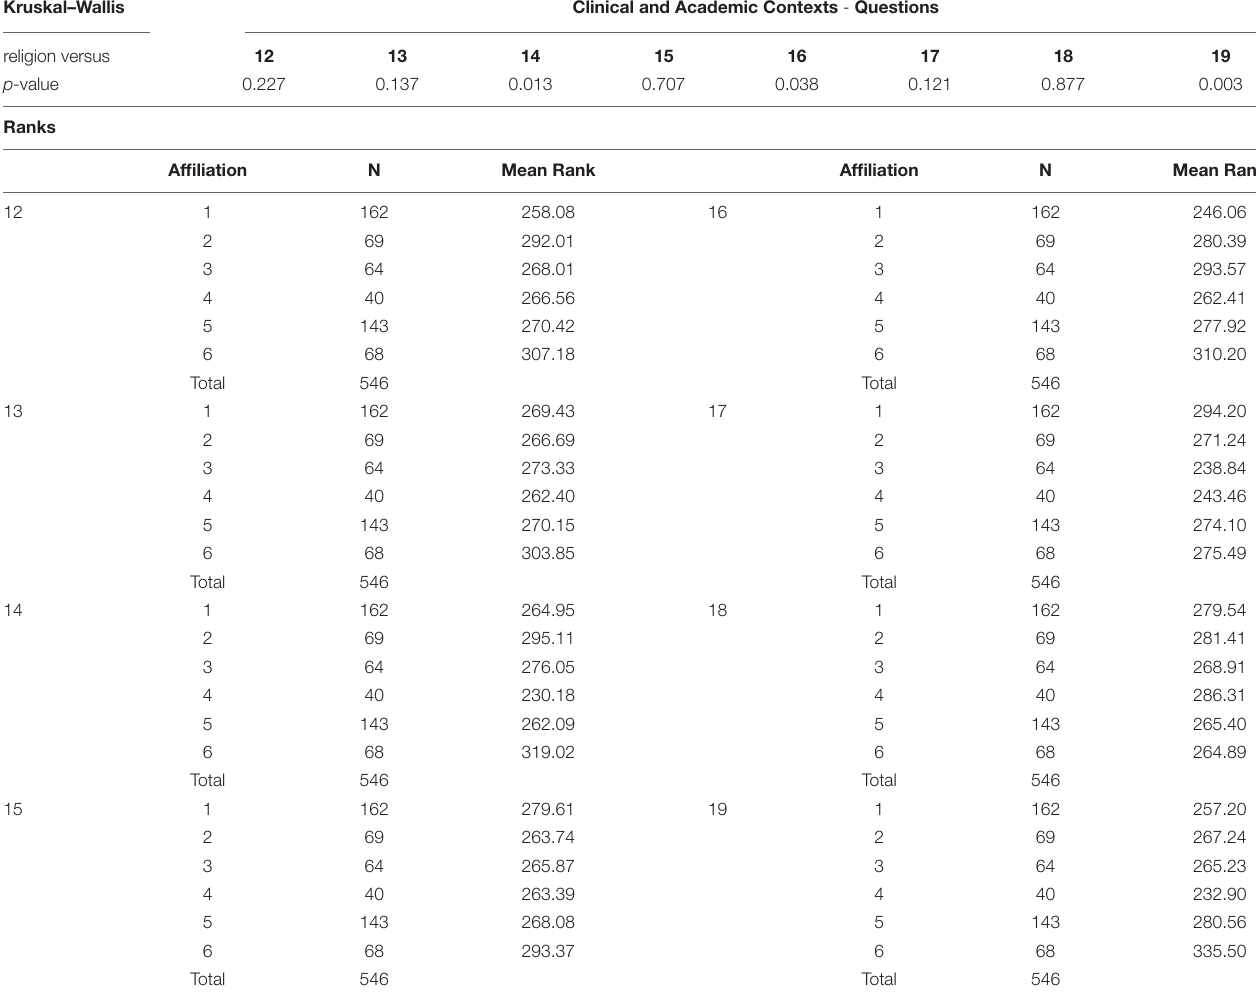
TABLE 12 | Kruskal–Wallis test - clinical and academic